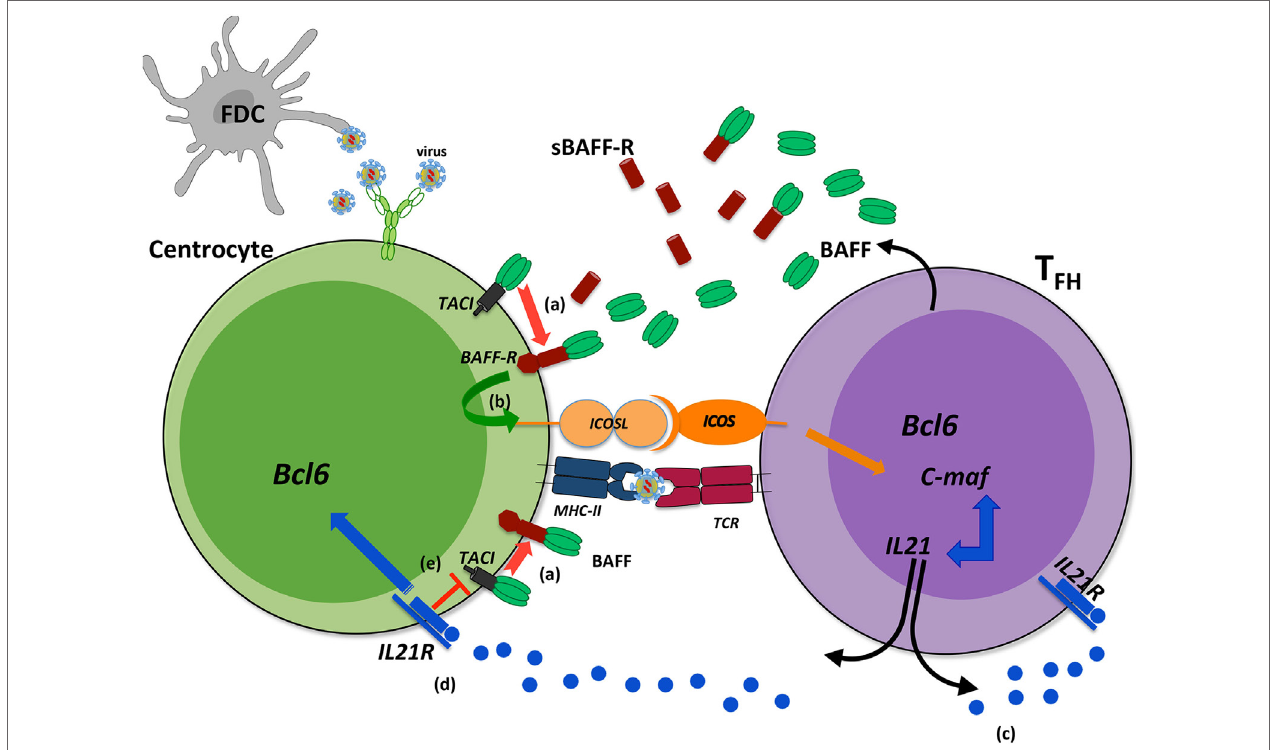
FiGURe 3 | Transmembrane activator and CAML interactor (TACI) as a key regulator of B-cell-activating factor (BAFF)-dependent BAFF-R cleavage in germinal center (GC). During a T-dependent response, follicular helper T-cells (T FH ) produce BAFF that can bind either to BAFF-R or to TACI. When BAFF is locally released in excess, its binding to BAFF-R can induce the cleavage of BAFF-R in a TACI-dependent manner from the surface of centrocytes (a). Reduced BAFF-R signaling leads to decreased ICOSL expression on B-cells (b) and therefore dampens ICOS signal, mandatory for T FH maintaining and IL21 production. This might constitute a physiological regulatory mechanism, exacerbated when high amounts of antigens are maintained within GC. IL21 is a key cytokine for T FH that ensures their survival (c) and that of light zone GC B-cells (d). In addition, IL21 decreases TACI expression that might prevent early TACI-dependent BAFF-R cleavage (e). Such regulatory roles would imply that IL21 and BAFF are produced sequentially during the GC reaction with possible consequences on recycling and differentiation of GC